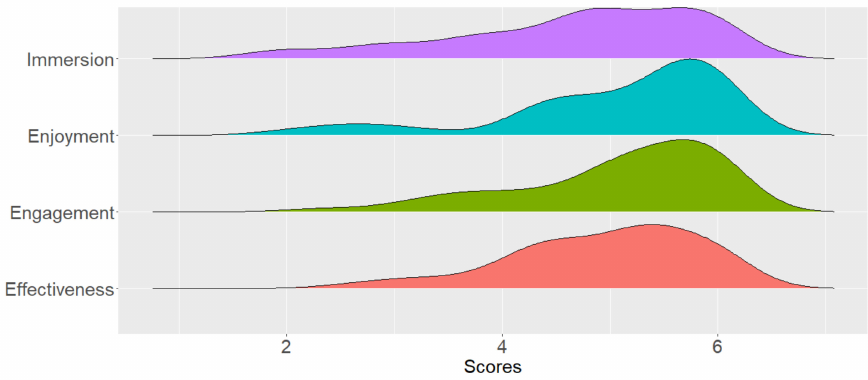
Figure 6. Distribution of the scores for the questionnaire factors. The average scores are high for all four factors, as confirmed by the density plot humps, and do not show particularly marked differences. The slightly higher coefficient of variation for Immersion indicates a slightly higher variability of scores for this factor. This is confirmed by the hump of the density plot, which for Immersion appears wider but is still oriented towards fairly high